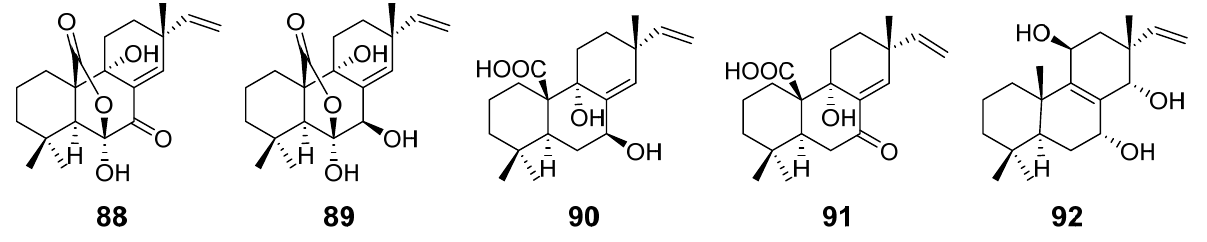
Figure 8. Structures of compounds 82 – 87 . Figure 9. Structures of compounds 88 – 92 .